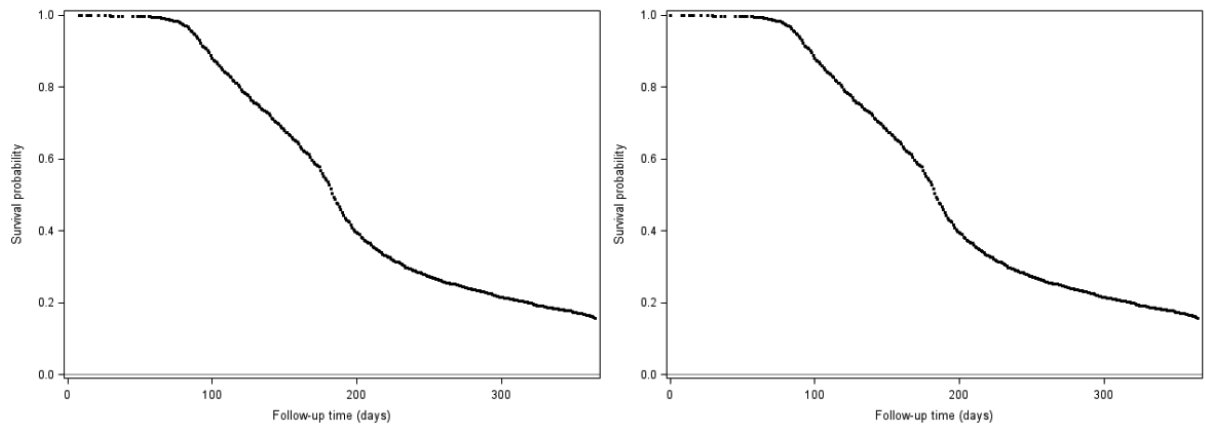
Table 6. Operational performance of the distributed regression analysis application. OverallCoxLogisticLinearPerformance metric —1,016.0925.5440.7Total run